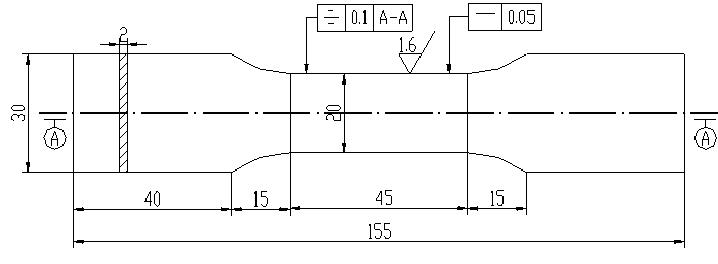
Figure 1. Tensile specimen size (unit: mm).